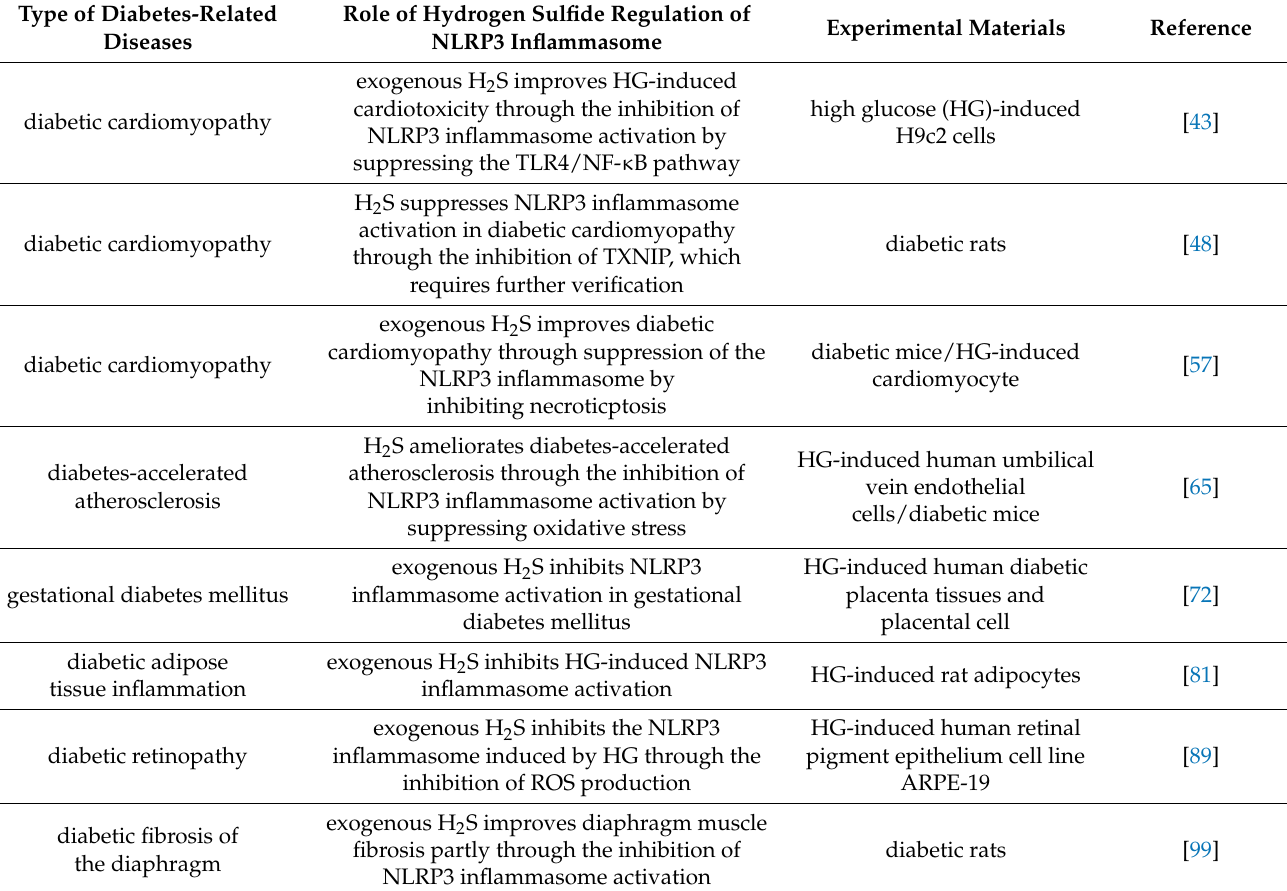
Table 1. Summary of the role of H 2 S in regulating the NLRP3 inflammasome in